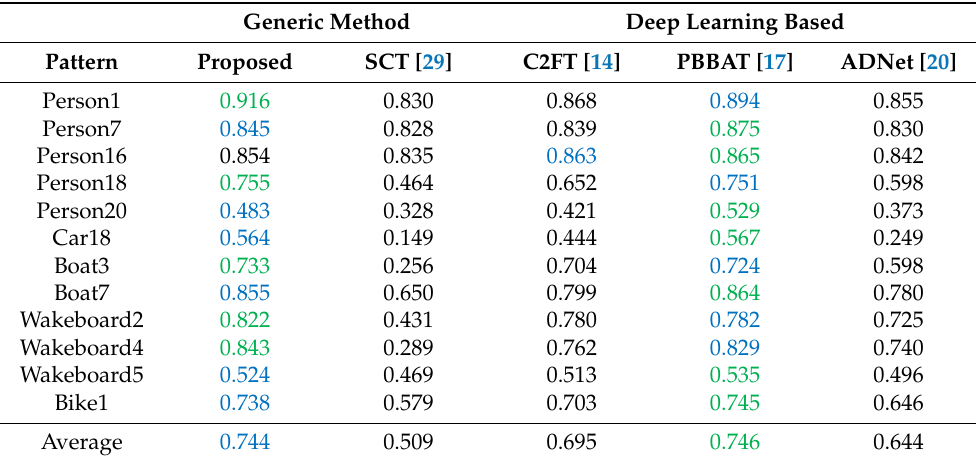
Table 1. The precision comparison result when threshold is set as 20. The best two precisions for each pattern are shown in blue and green colors, respectively.